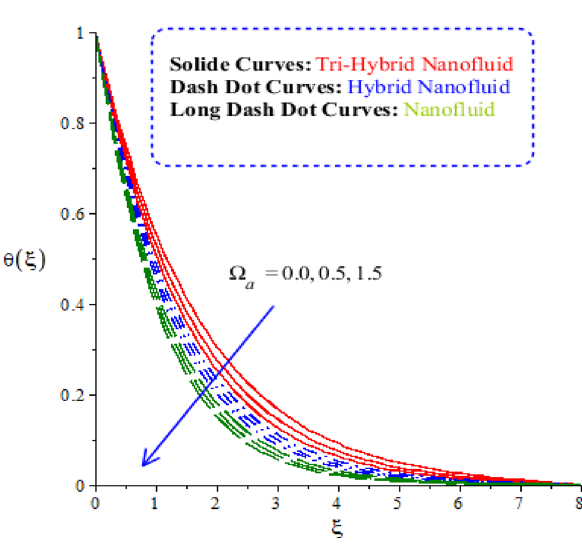
Figure 9. Comparative variation of temperature curves among nanoparticles versus (cid:31) a